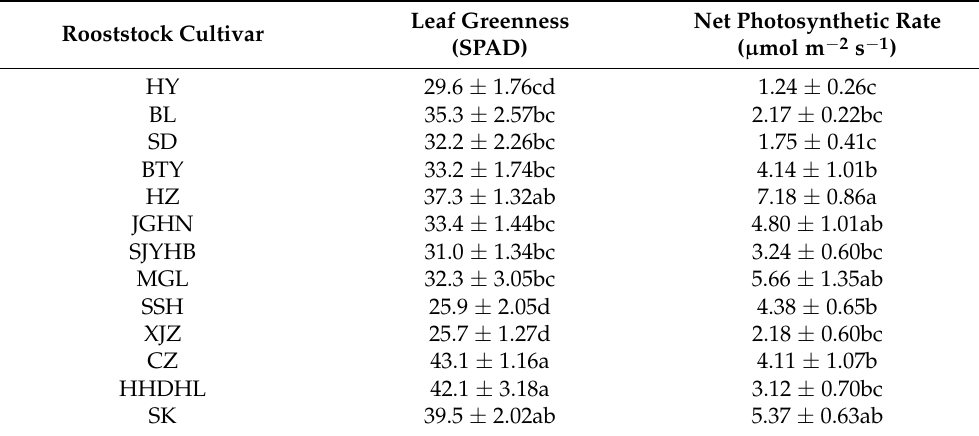
Table 3. Leaf greenness and net photosynthetic rate among trees with different rootstocks. Rooststock